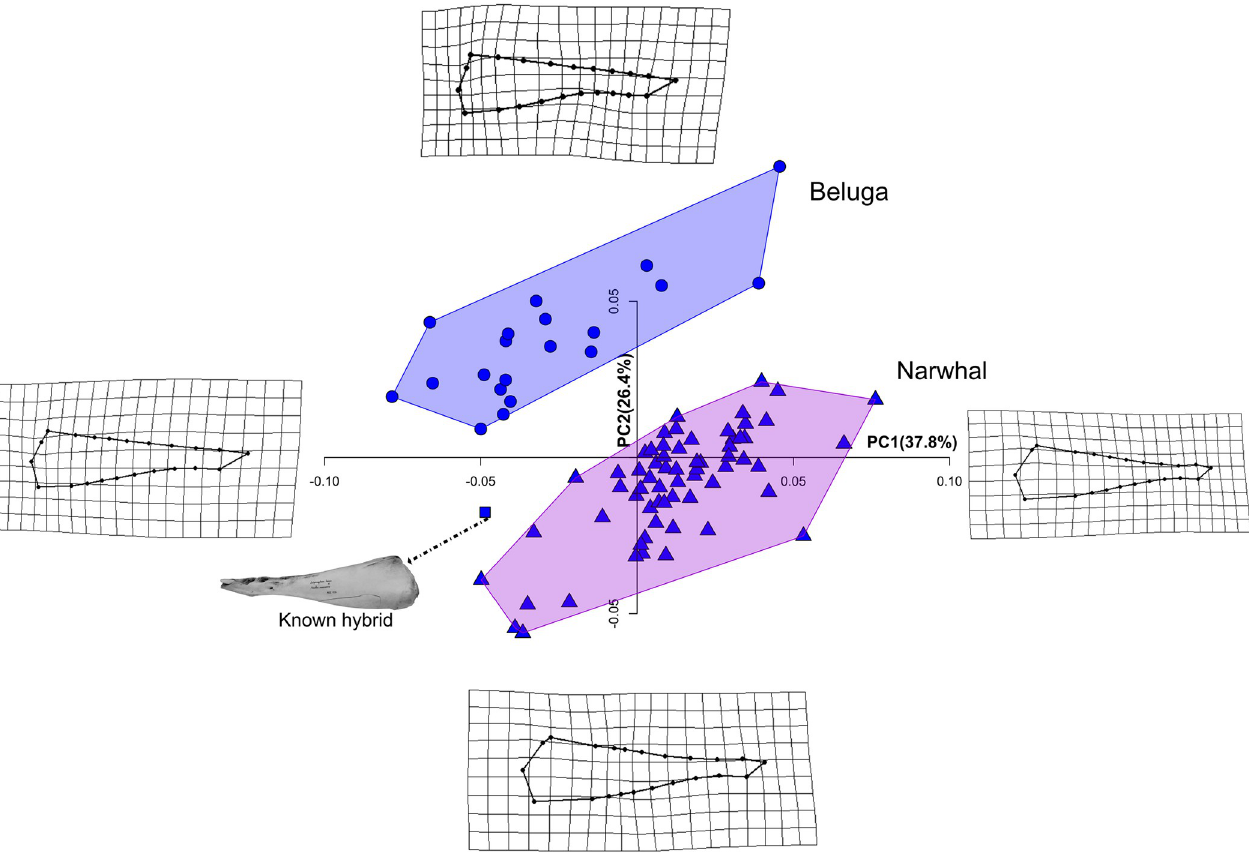
Fig 5. PCA on hemi-mandibles. Principal Component (PC) plot for the two-dimensional (2D) hemi-mandible monodontid dataset. Shape differences along the axis of the PC1 and PC2 are visualized with thin plate spline deformation grids. See text for details.